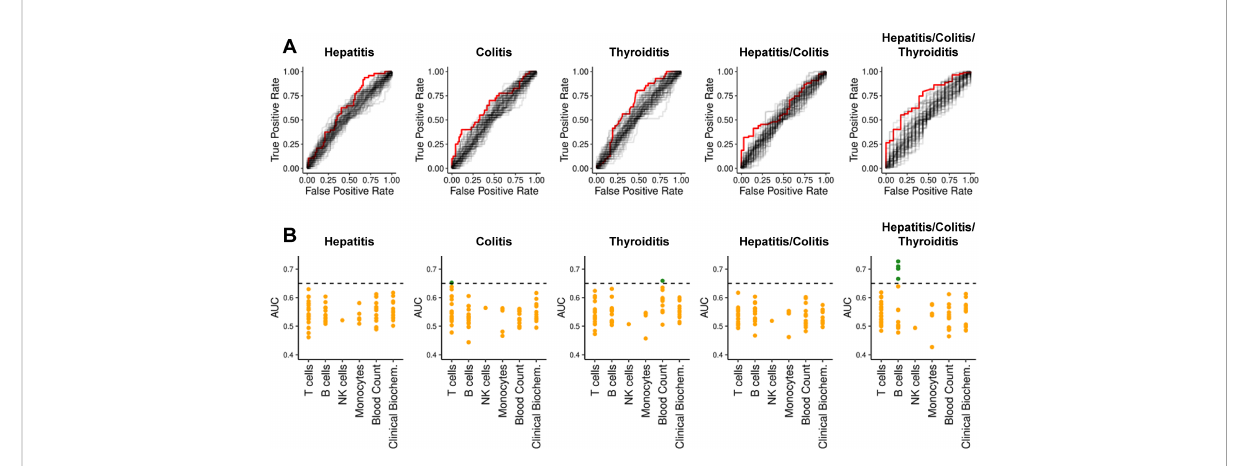
FIGURE 1 ROC-curves and AUCs for previously reported biomarkers and clinical parameters per condition. (A) ROC-curves for all 68 features regarding each dependent variable are shown. For each dependent variable, the features with highest AUC is highlighted in red. (B) AUCs from ROC- curves in sub fi gure (A) grouped according to immunological classes. The y-axis represents the AUC. Orange dots denote AUC ≤ 0.65; green dots denote AUC >